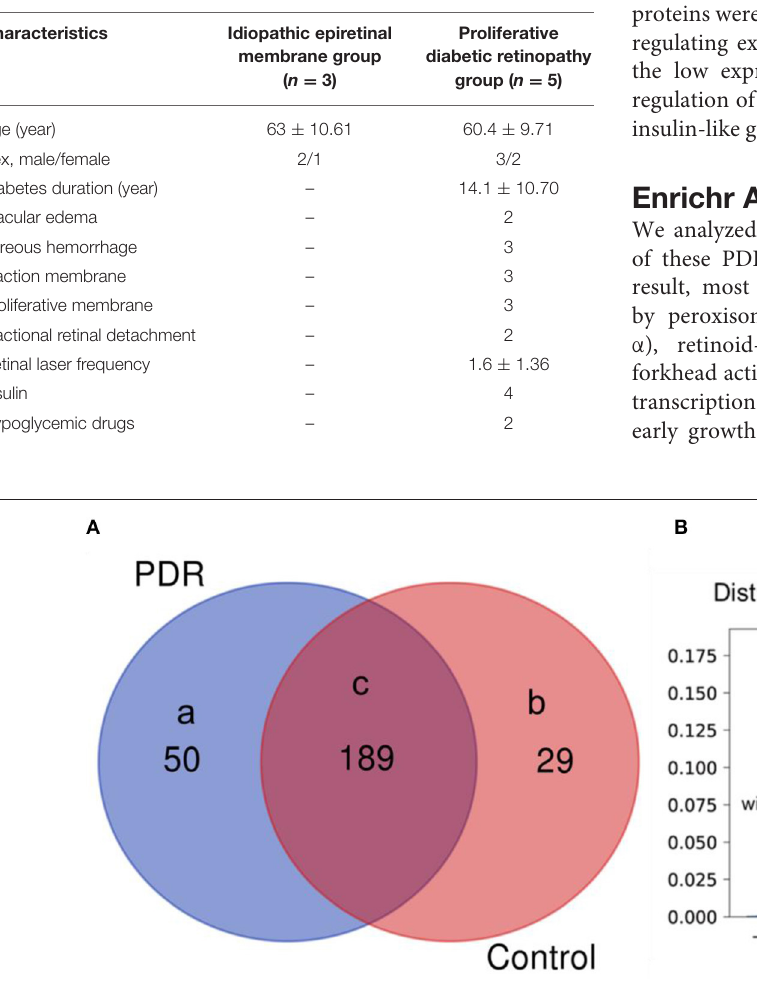
FIGURE 1 | Differentially expressed proteins between PDR patients and control. (A) Proteins detected in (a) only PDR group ( n = 5), (b) only control group ( n = 3), (c) both groups. (B) Distribution of protein expression level in PDR patients (log2 fold change of expression level in PDR to control, x-axis) and significance ( P -value,